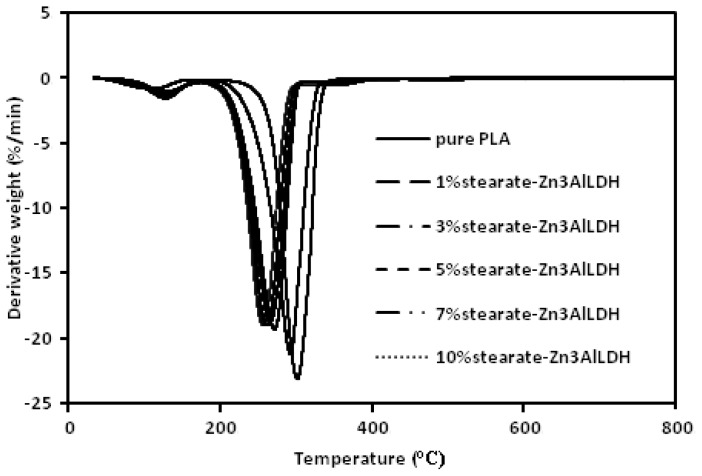
Differential thermal analysis (DTA) of the pure PLA and its stearate-Zn3Al LDH nanocomposites.